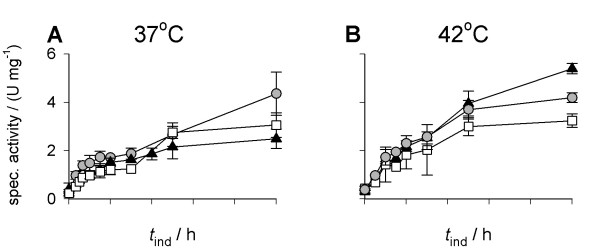
Impact of production temperature on reactivation of α-glucosidase from inclusion bodies. Inclusion bodies of α-glucosidase were produced for two hours at 37°C (A) or 42°C (B) in ibpAB deletion mutant (white square), wildtype strain without (grey circle) or with ibpAB overproduction (black triangle). Specific activity of α-glucosidase was measured during incubation at 30°C after addition of tetracycline. Mean values and 95% confidence intervals from six (37°C) or four (42°C) independent experiments. Time is given in hours after induction.